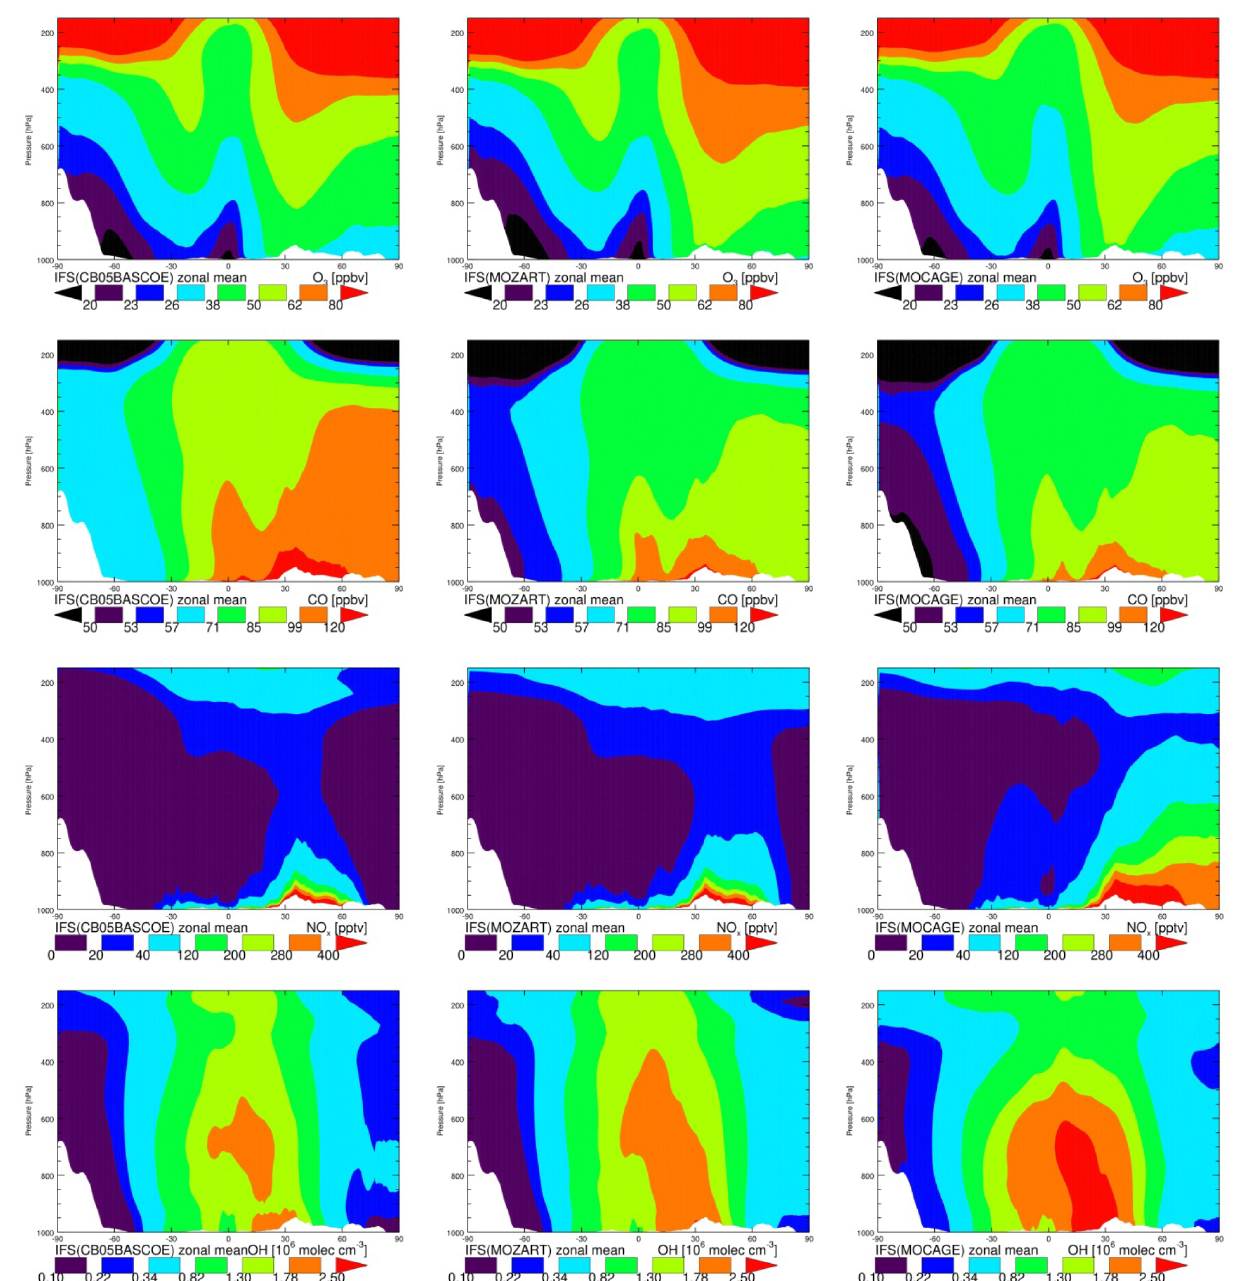
Figure 3. Zonal annual mean O 3 , CO, NO x , mixing ratios and OH concentrations in CBA (a) , MOZ (b) and MOC (c)